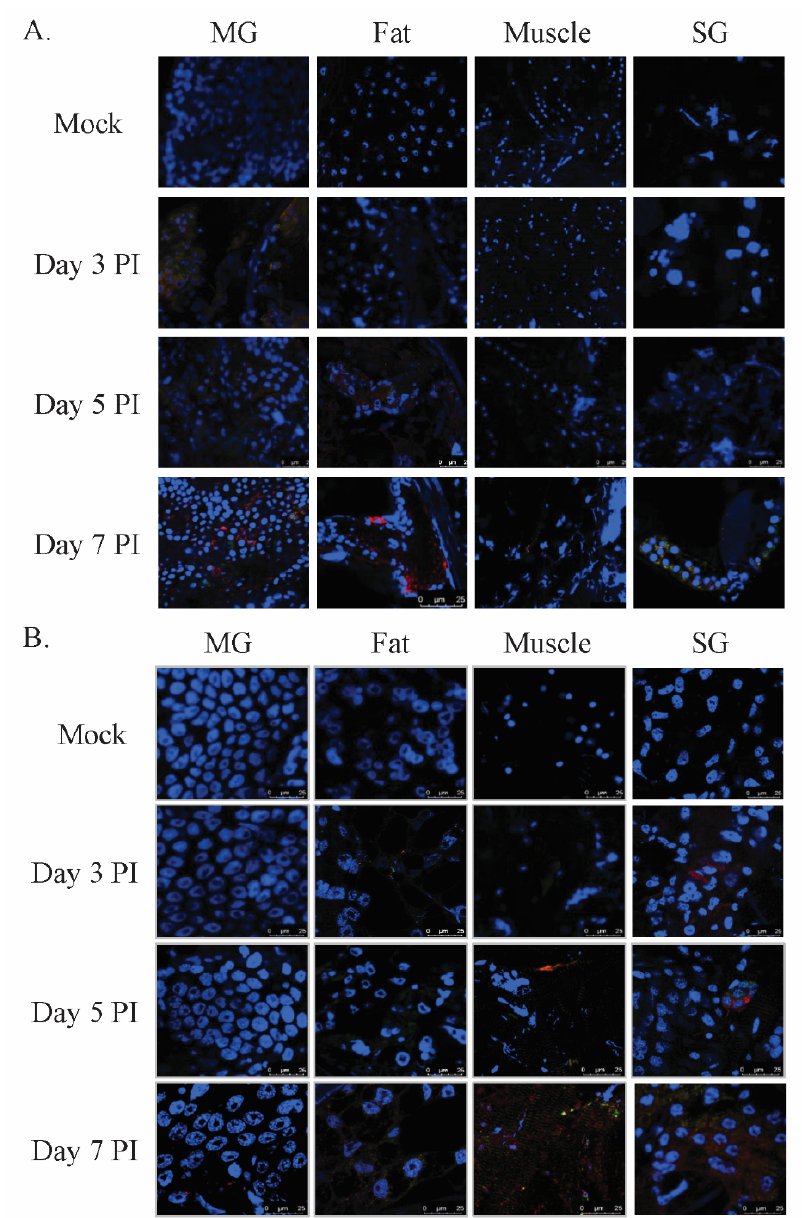
Figure 3. DENV2 progression in infected mosquito bodies. Mosquitoes were infected orally ( A ) or via thorax injection ( B ) with DENV2 and then incubated. At days three, five and seven post-infection (PI), mosquitoes were harvested and dissected to obtain midgut (MG), fat, muscle and salivary glands (SG). All of these tissues were stained with anti-NS1 Ab (red), anti-E Ab (green) and DAPI (blue). The processed tissues were analyzed using confocal microscopy.